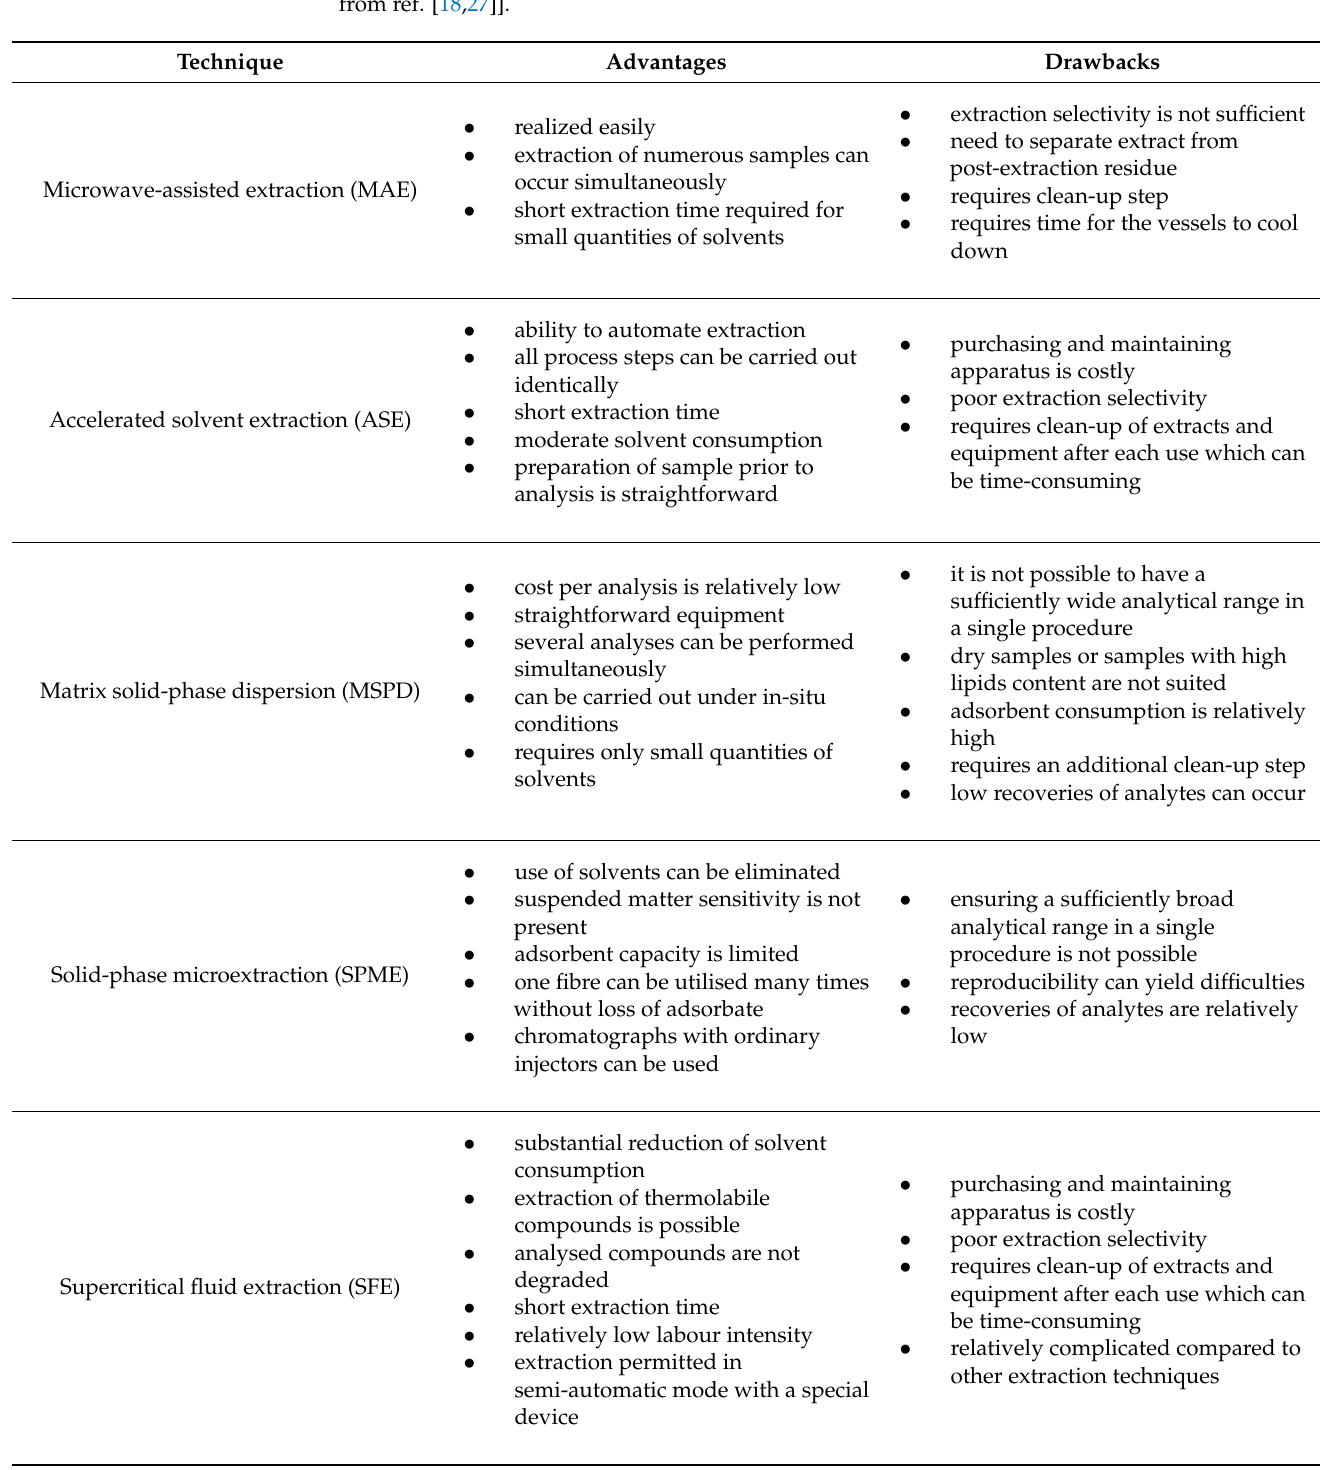
Table 2. Pesticide identification techniques and associated advantages and drawbacks [table adapted from ref.